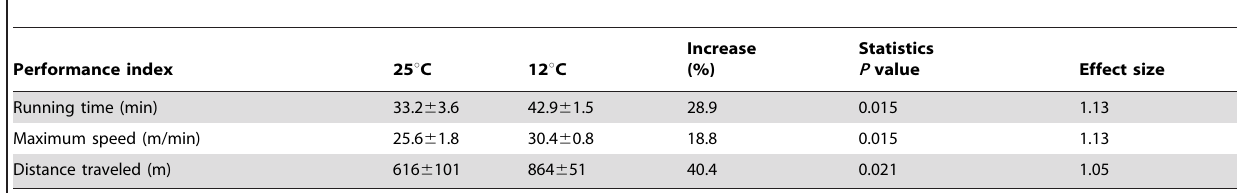
Table 1. Indexes of physical performance in rats subjected to incremental-speed exercises at ambient temperatures of 12 and 25 u C.